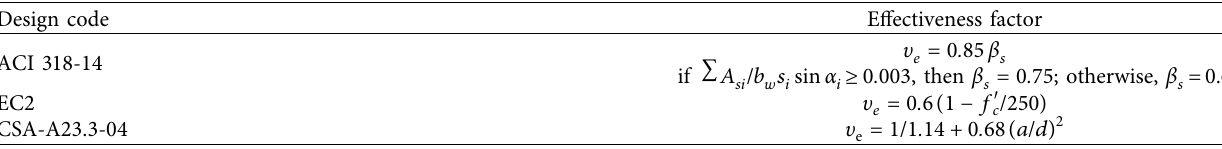
Table 6: Different design codes effectiveness factor.